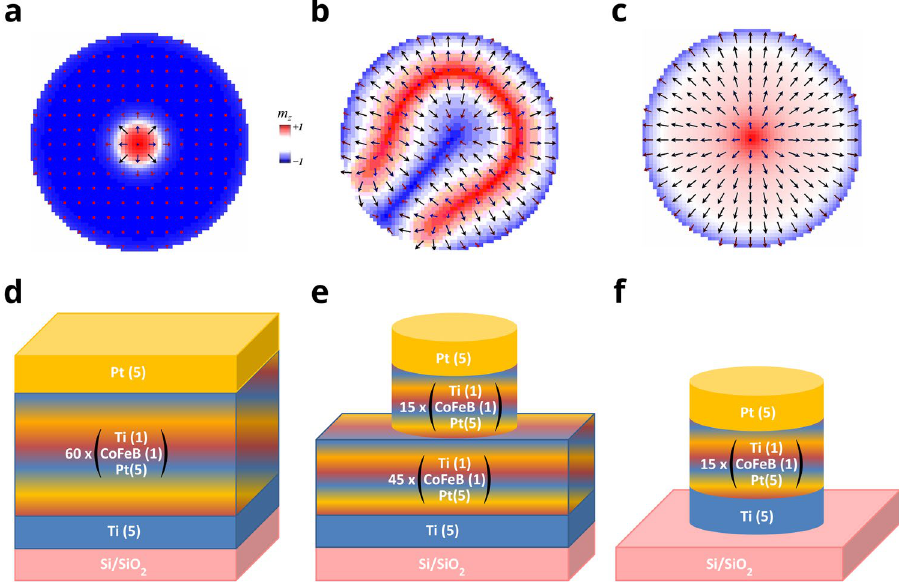
Figure 1. Schematic of Spin textures and three sample types Schematic drawing of ( a ) Néel Skyrmion ( b ) Horseshoe, ( c ) Radial Vortex, ( d ) 60 repeat continuous film, sample 60 C, ( e ) 15 repeat partially patterned, sample 15PP-A f) 15 repeat fully patterned, sample 15FP-AI. Sample label conventions are defined in Table 1.